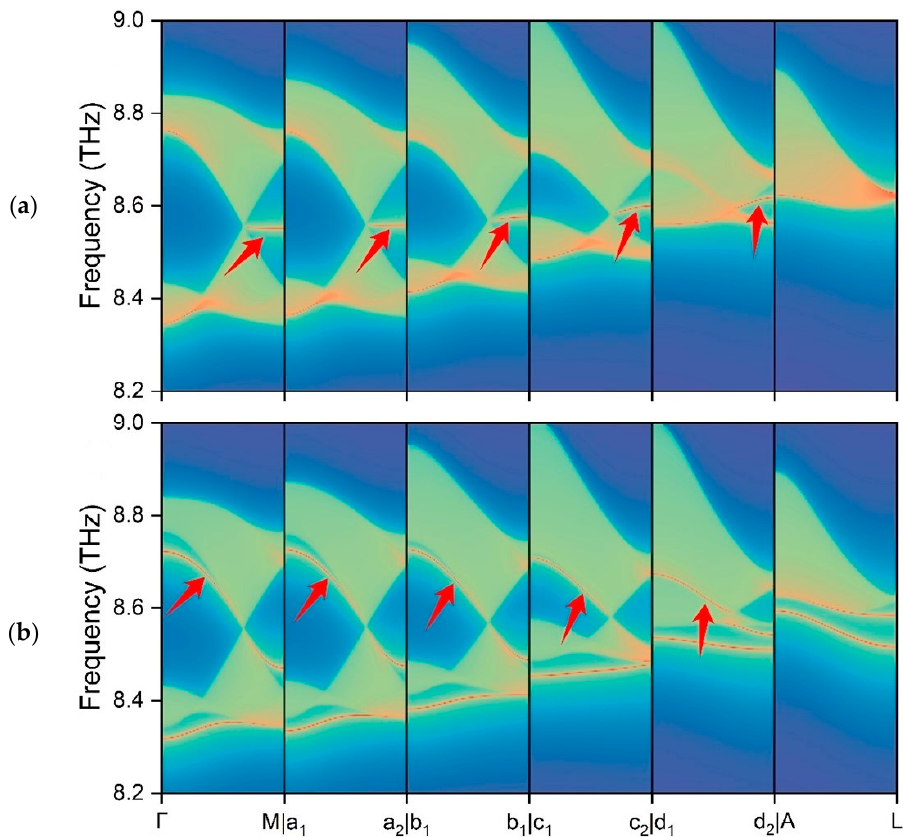
Figure 5. The calculated surface spectrum along the (010) surface for the top ( a ) and bottom ( b ) terminations, respectively. The drumhead surface states are indicated by the red arrows.